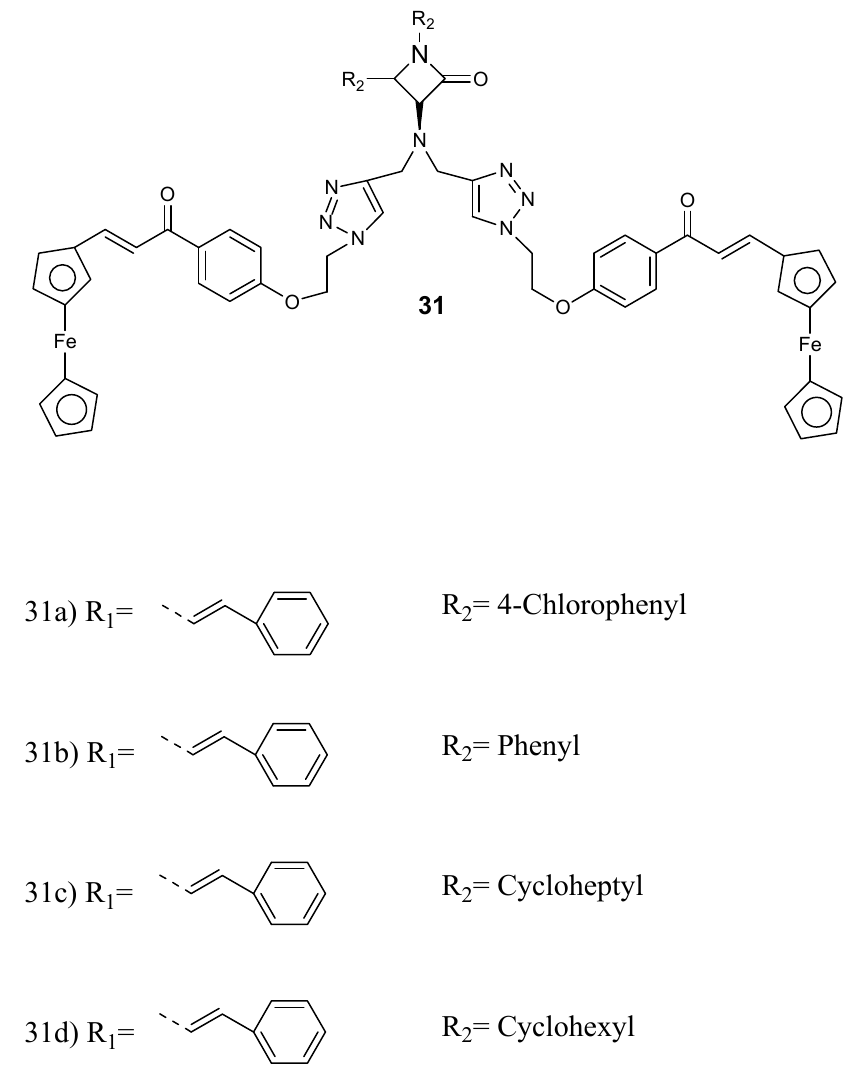
Figure 15. Structure of ferrocenylchalcone–b-lactam hybrid compounds 31a – d.